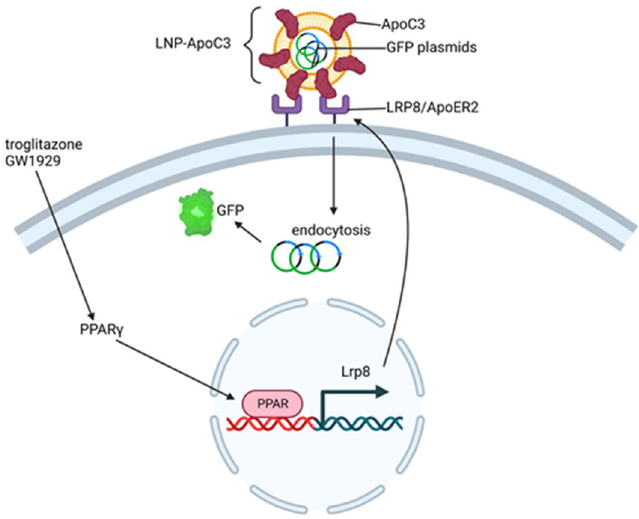
Figure 7. Schematic showing the role of ApoC3 in potentiating LNP internalization by interaction with ApoER2. Based on our data, we propose that one of the ways ApoC3 potentiates internalization of LNPs into BMMCs could be through interaction with the cell surface receptor ApoER2. LNPs are internalized via clathrin- mediated endocytosis that also requires actin-polymerization. Internalization results in expression of green fluorescent protein (GFP) encoded by the plasmid cargo. PPARγ is a transcription factor that can regulate the expression of many genes. Activation of PPARγ by agonists such as troglitazone and GW1929 reduces Lrp8 transcription and causes a corresponding decrease in ApoER2 protein expression, resulting in reduced ApoC3- LNP